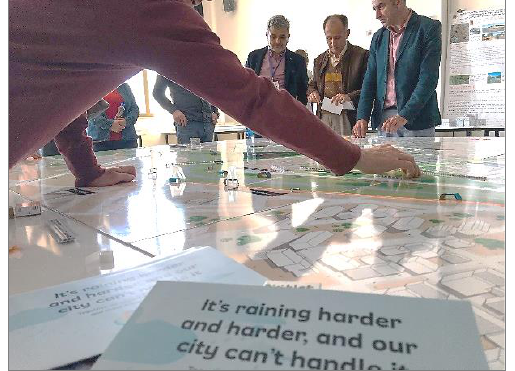
Figure 13 Cycling and experiencing the site before Sustainable Mobility game session